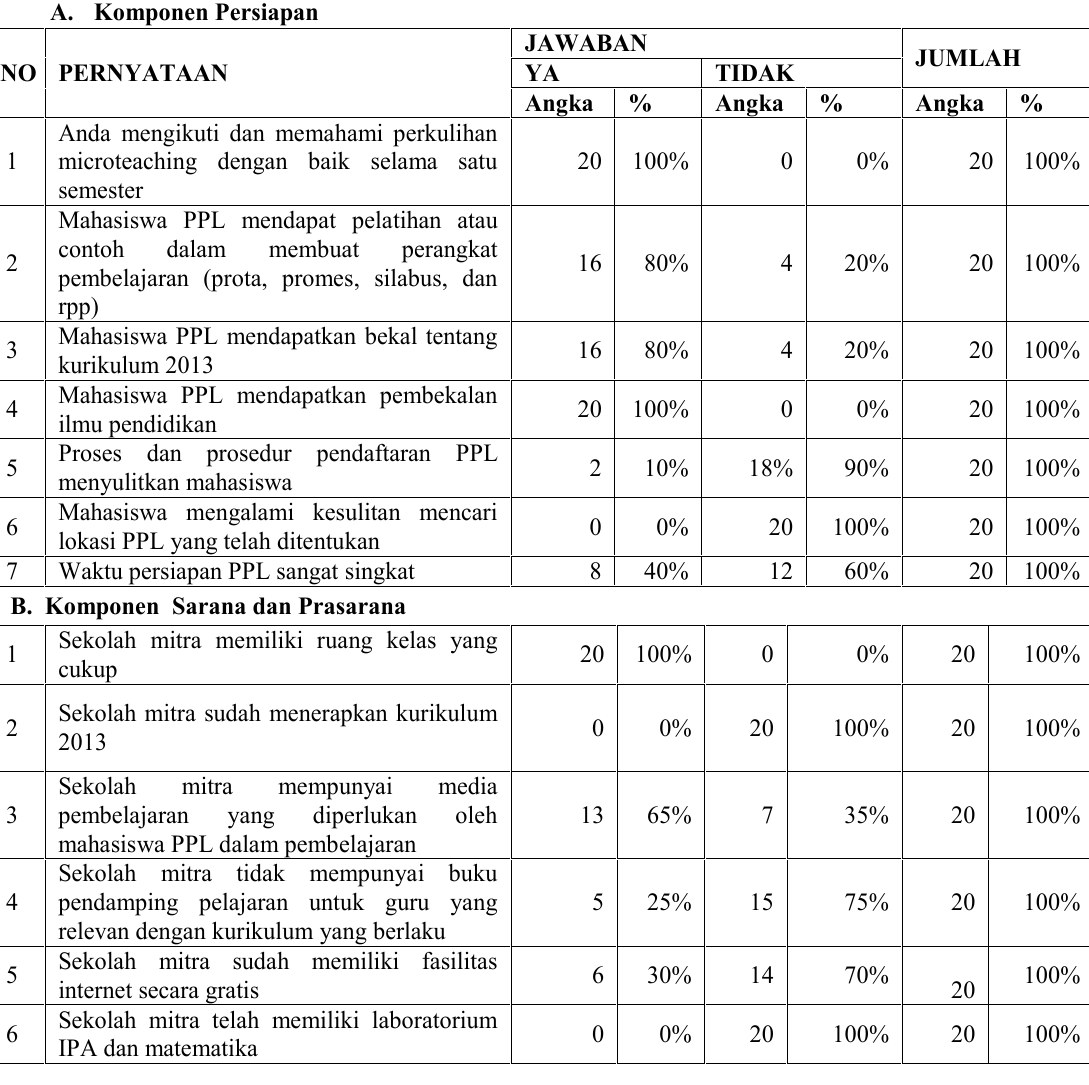
Tabel 2. Rekapitulasi Data Hasil Angket Persepsi Mahasiswa terhadap Pelaksanaan PPL PGSD FKIP UMS Tahun 2013/2014 di Sekolah Mitra dengan Mutu